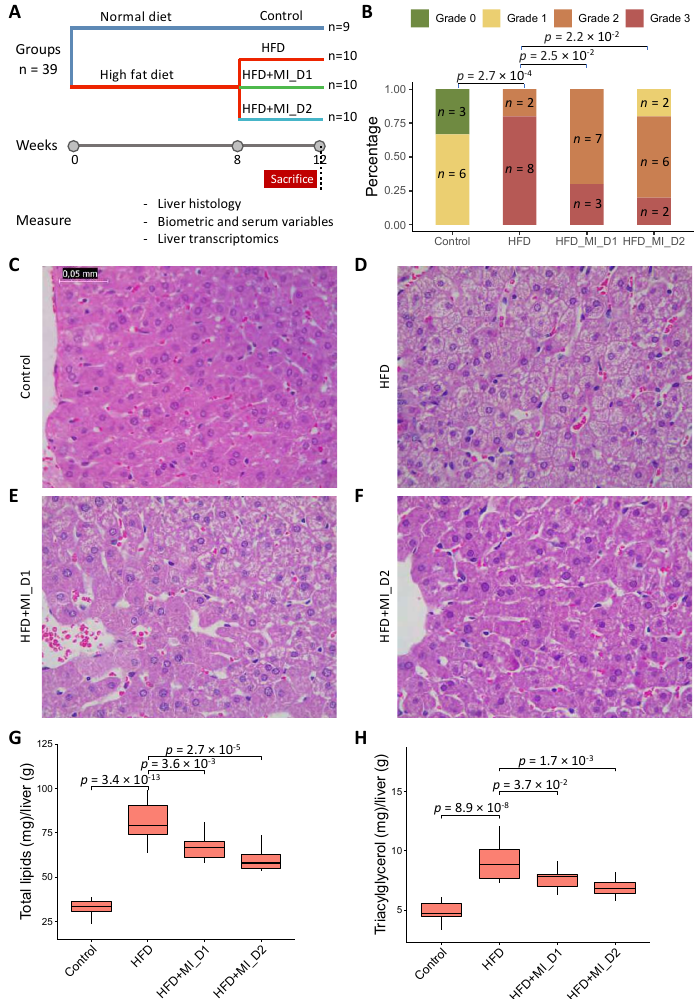
Figure 1. Effect of HFD and CMA treatment with two doses on liver histology of Golden Syrian hamsters. ( A ) Study design. ( B ) Steatosis score of histological changes in liver. ( C–F ) Histological analysis of steatosis in liver sections stained with Hematoxylin and Eosin (400 ×). ( G ) Relative hepatic total lipid content of hamsters in experimental groups. ( H ) Relative hepatic triacylglycerol level of hamsters in experimental groups. Control, normal diet; HFD, high-fat diet; HFD+MI_D1, high-fat diet supplemented with CMA at Dose I; HFD+MI_D2, high-fat diet supplemented with CMA at Dose II. Differences among groups in steatosis score were assessed using a Chi-squared test. Differences among groups in hepatic total lipid content and triacylglycerol level were derived from one-way ANOVA followed by Tukey’s post-hoc test. All results were considered statistically significant at p -value < 0.05.